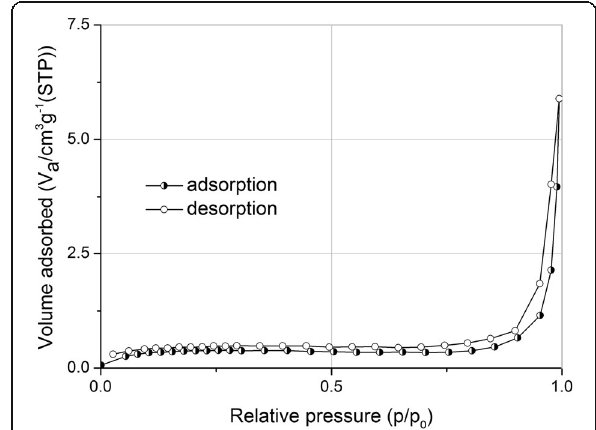
Fig. 3 Nitrogen adsorption/desorption isotherm for freeze-drying PHEMA sample synthesized with porogen (No